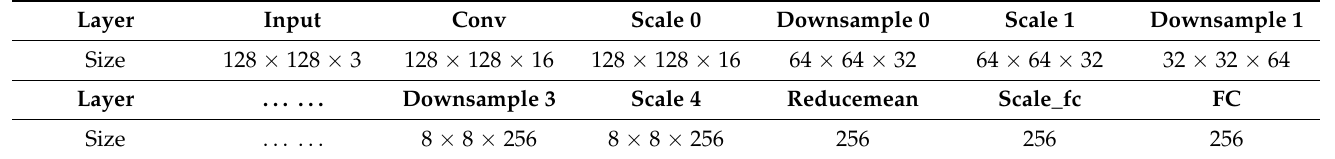
Table 1. Output size of the layer in the encoder